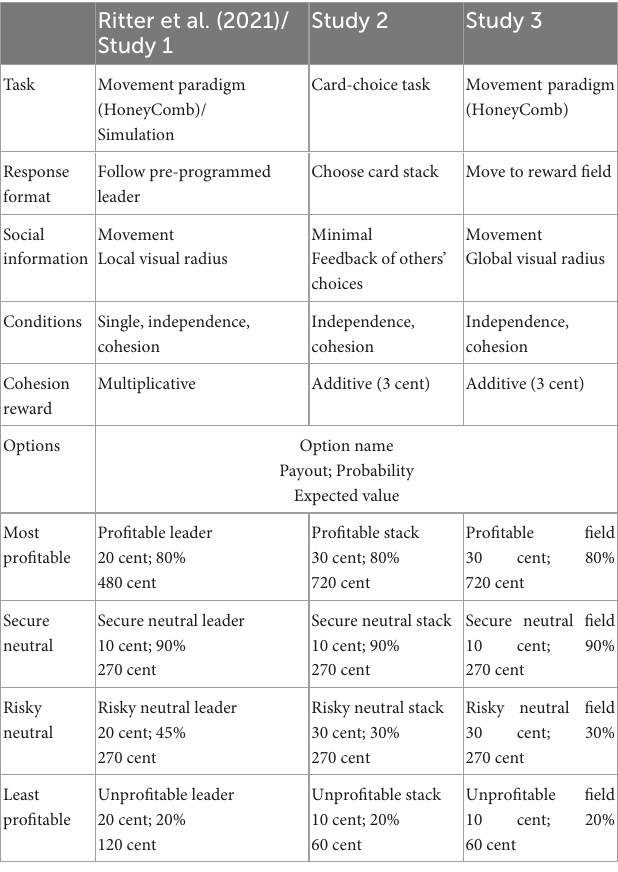
TABLE 1 Overview over experimental conditions and options in Study